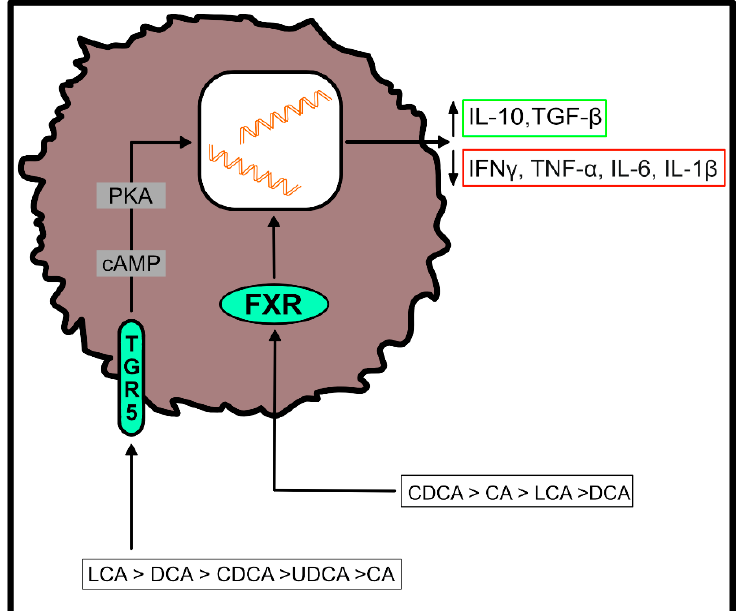
Figure 2. Effects of bile acid (BA) receptor engagement on immune cell function. After binding to the farnesoid X receptor (FXR) or the G protein-coupled receptor (TGR5), primary and secondary BAs shift the cytokine profile of myeloid cells to an anti-inflammatory phenotype. Their agonistic functions thereby depend on the affinity of individual BAs for the respective receptor, as indicated in the figure [51]. (IL-10 = interleukin-10; TGF- β = transforming growth factor beta; IFN γ = interferon gamma; TNF- α = tumor necrosis factor alpha; IL-6 = interleukin-6; IL-1 β = interleukin-1 beta).